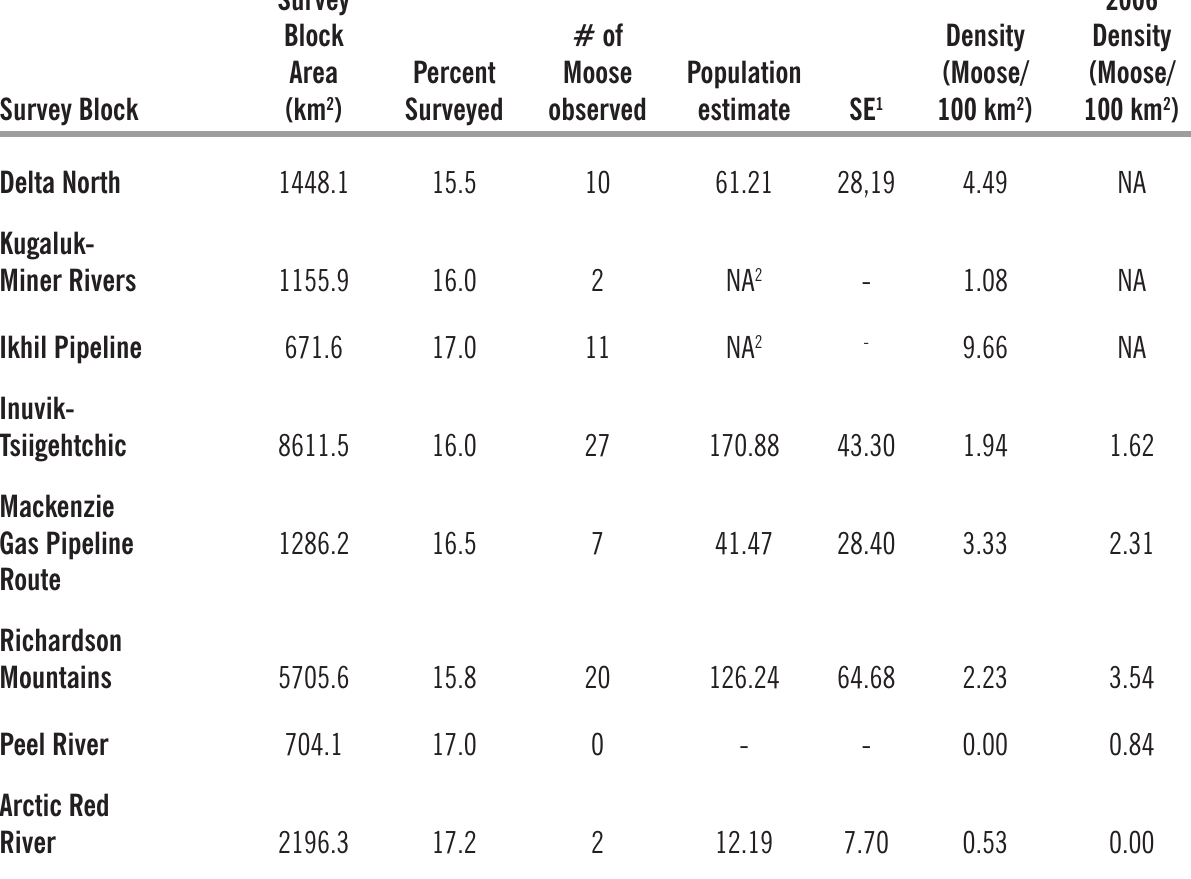
Table 1. Number (#) of moose observations, moose densities, and population estimates by survey